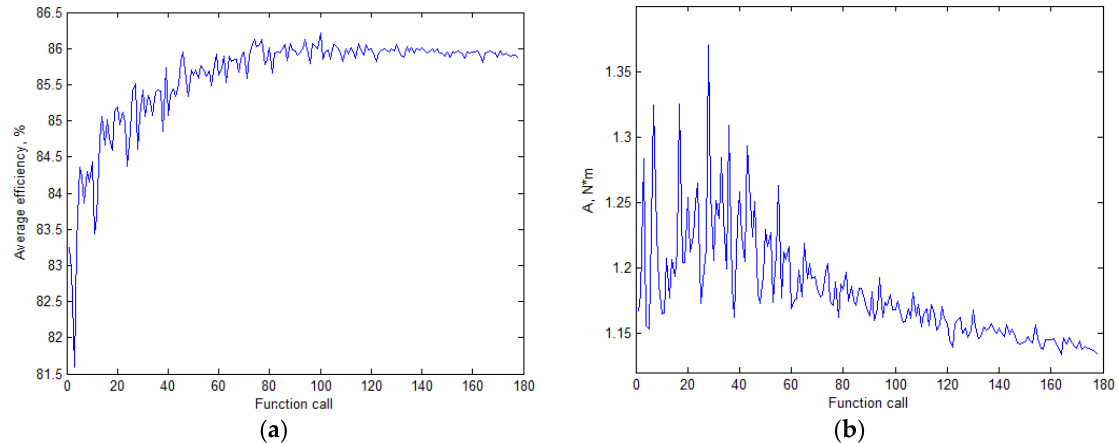
Figure 7. ( a ) Variation of the average efficiency during the optimization; ( b ) variation of the torque oscillations during the optimization.